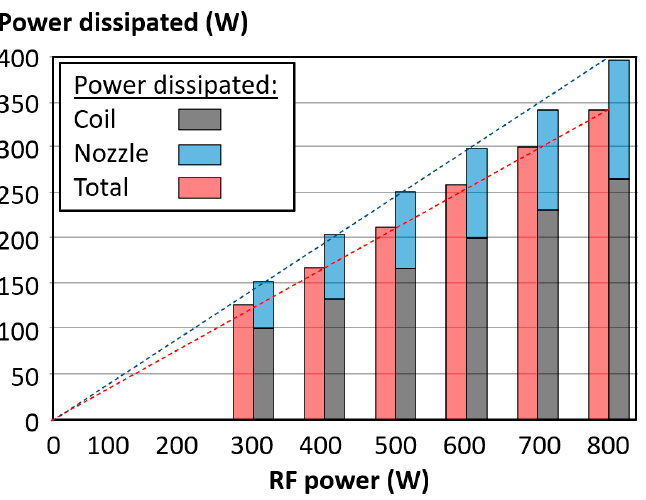
Figure 10. RF power versus power dissipated for each coolant channel.